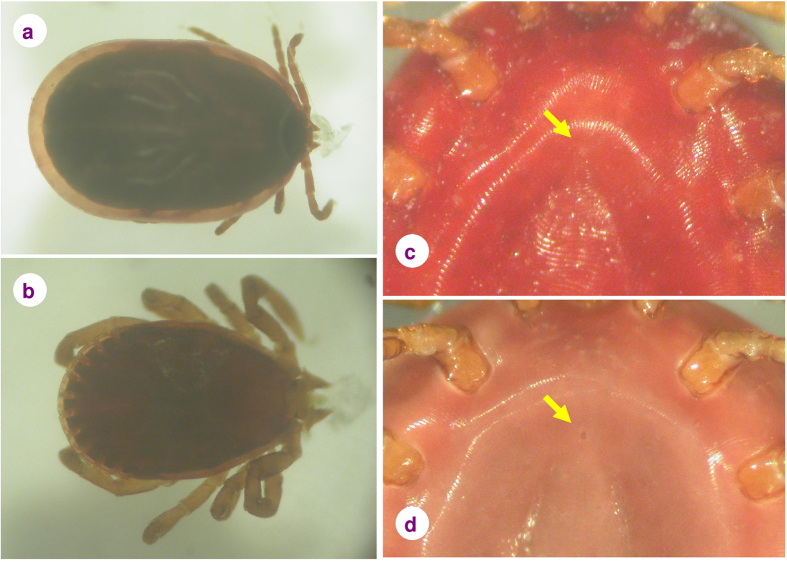
Haemaphysalis concinna nymphs showing apolysis: (a) when close to full engorgement, (b) at the beginning of engorgement. Compared to nymphs that did not show the signs of apolysis (c), the place of the genital pore (arrow) was more apparent on apolytic nymphs (d).